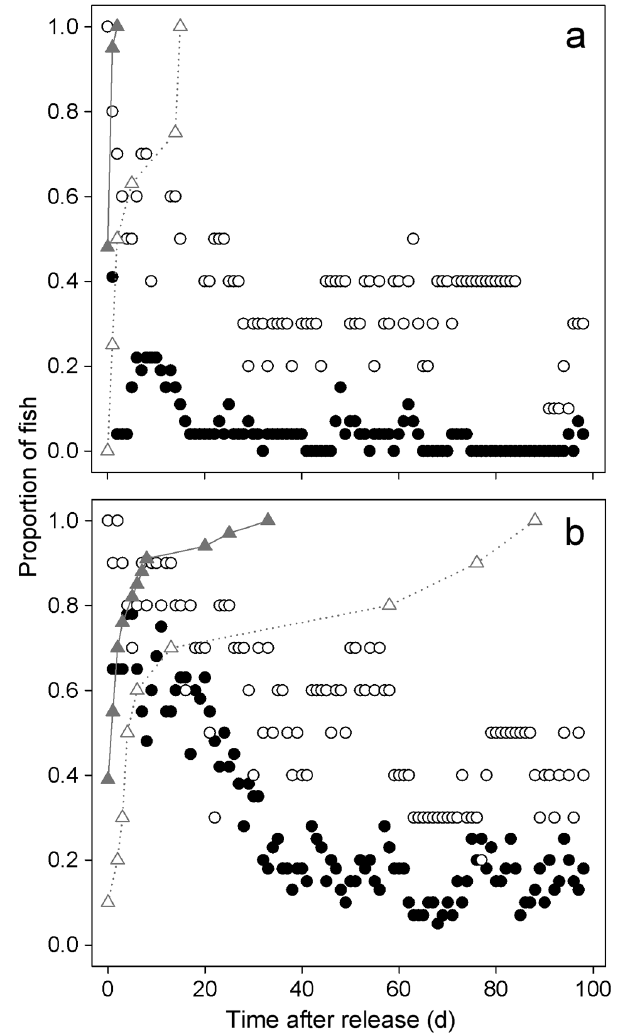
Fig. 2. Oncorhynchus mykiss . Daily proportion of acousti- cally tagged farmed rainbow trout present at 2 commercial aquaculture sites in Lake Huron, (a) Farm 1 and (b) Farm 2, from which they were released. Fish were monitored for 14 wk in 2008 (open circles; 2 July to 19 October) and 2009 (solid circles; 15 May to 20 September). Also shown is the cumulative time required for all rainbow trout to initially dis- perse from release sites (defined as not detected by the farm receiver for a period of 24 h) in 2008 (open triangle, dashed line) and 2009 (solid triangle, solid